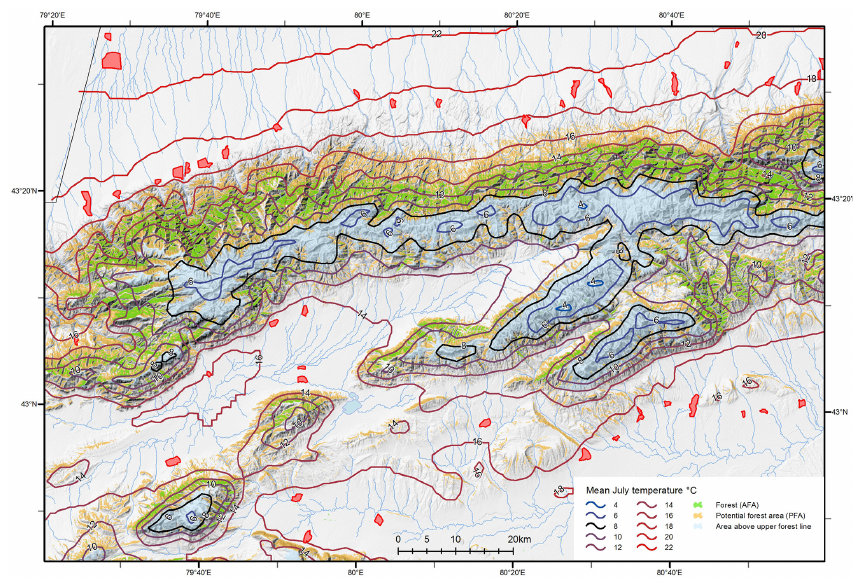
Figure 9. Distribution of AFA and PFA and the July